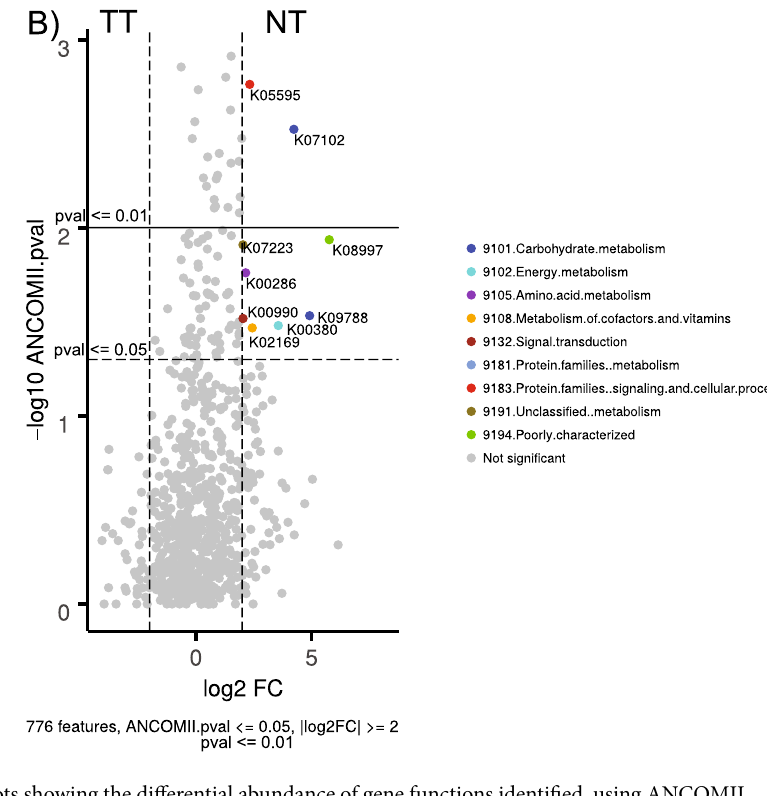
Figure 5. Volcano plots showing the differential abundance of gene functions identified, using ANCOMII analysis, between normal mucosa and tumor tissue. Two subsets of samples were used for this analysis: ( A ) all samples, ( B ) only samples with more than 127 reads in both samples in the pair. Features are sorted by p value. Significant dots showing features above p -value < 0.05 (dashed line) |log fold change (log2FC) > = 2, and p -value < 0.01 (solid line) | log2FC ≥ 2, are colored according to the subcategory they belong